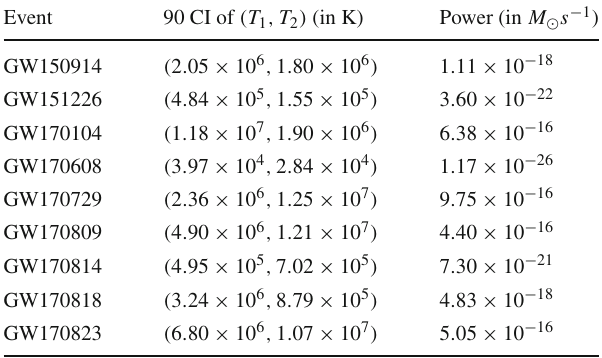
Table1 The90%ofconfidenceinterval(CI)of T eff ,inthedetectframe, for the O1 and O2 binary black hole coalescence detected by Advanced LIGO and Virgo. The black hole radiation luminosity at the 90% CI of T eff is also computed. The corresponding black hole radiation power is considerably smaller that the order of magnitude of the peak GW luminosity, suggesting no evidence of strong quantum gravity effects Event 90 CI of ( T 1 , T 2 ) (in